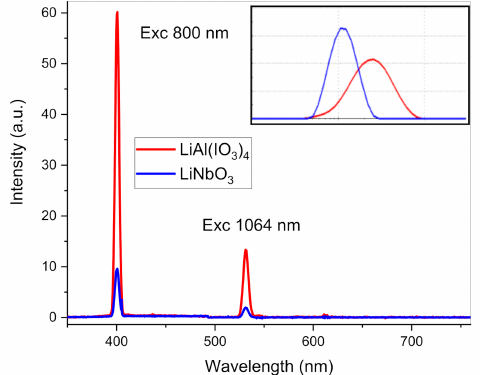
Figure 6. SH scattered intensities collected from a LiAl(IO 3 ) 4 (red curve) and a LiNbO 3 (blue curve) nanocrystal suspension with similar XRD crystallite sizes and mass concentrations for two excitation wavelengths fixed at 800 nm and 1064 nm. In the inset, the corresponding DLS size distributions in intensity are plotted, showing a higher aggregation state within the supernatant of the LiAl(IO 3 ) 4 suspension.